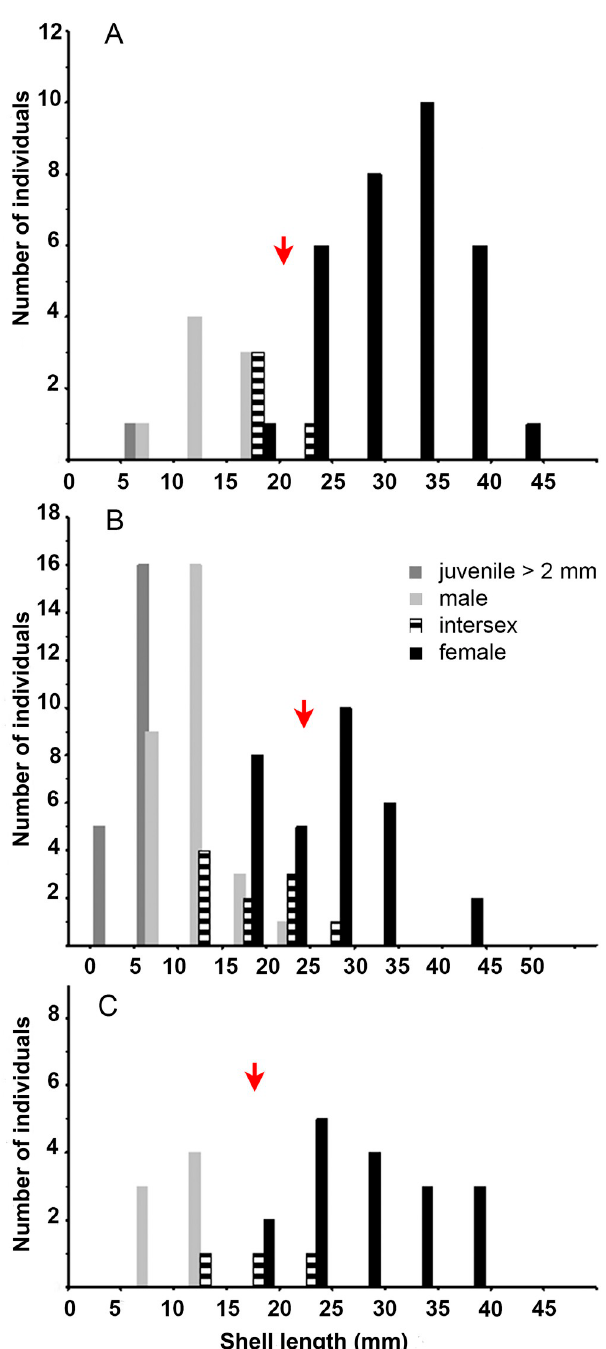
Fig 5. Size-gender distribution of Crepipatella dilatata . (A) El Arbeyal. (B) O Grove 2012. (C) O Grove 2016. Red arrow in A-C marks the estimated L 50 . and only ready-to-hatch juveniles were found. In each sample, within a brood, the develop- ment of viable embryos was synchronous, but among females development was asynchronous. From some broods collected in O Grove in April 2016, offspring hatched as crawling juveniles or pediveligers (less than 10%).